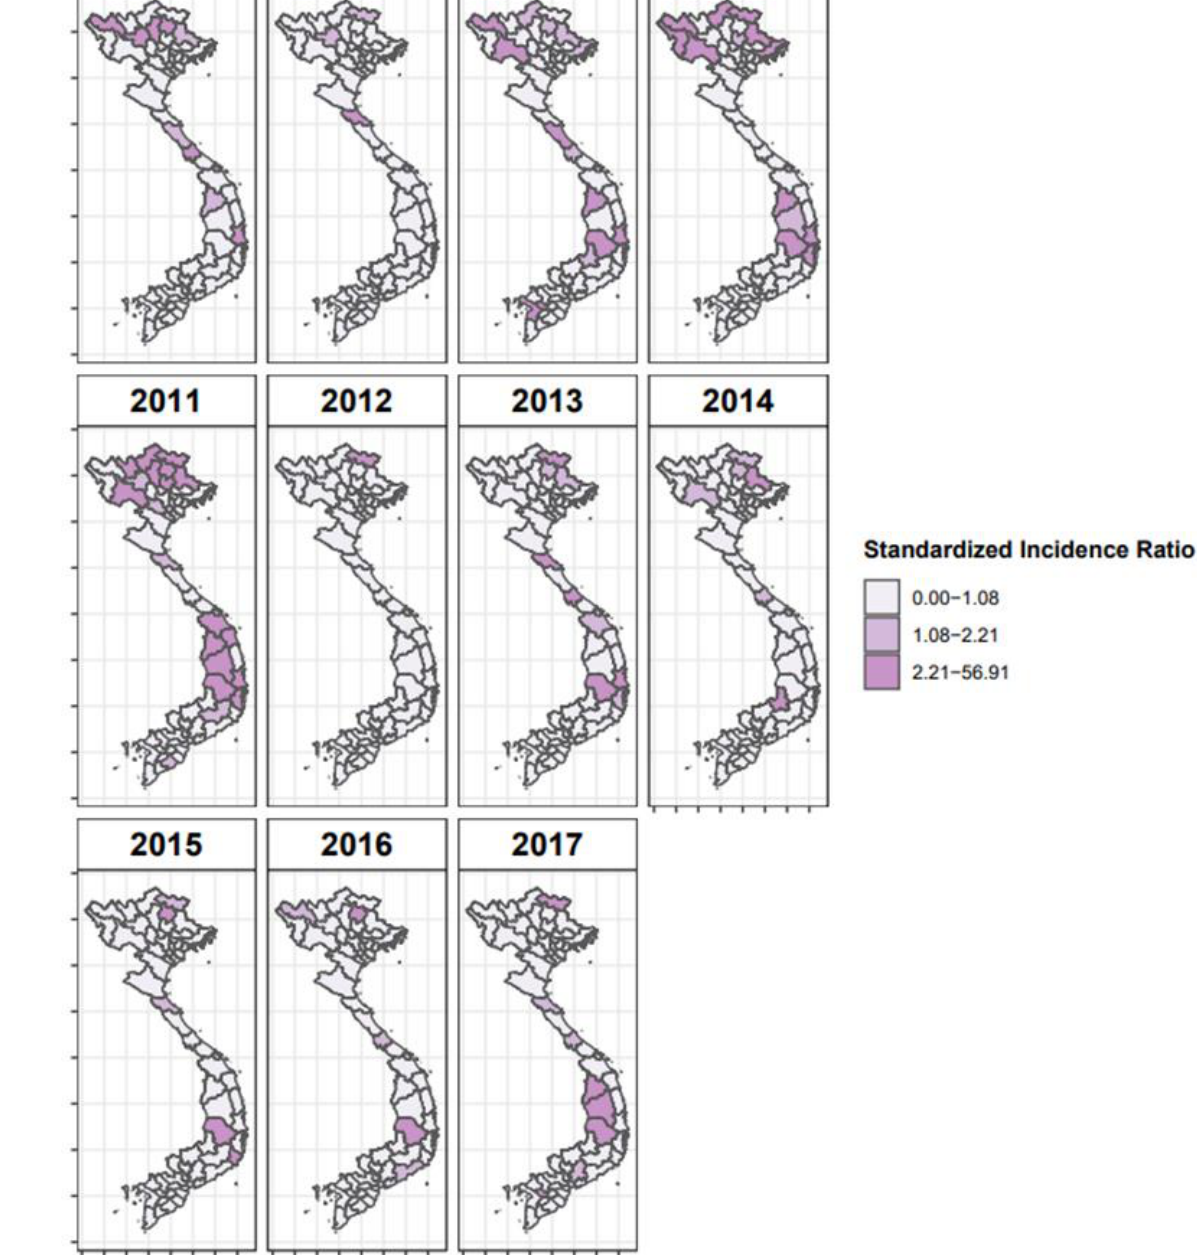
Figure 3. Map of standardized incidence ratios for years 2007–2017 in Vietnam considering the reported outbreak numbers of cattle and buffaloes. Darker areas indicate high-risk provinces during the study period.